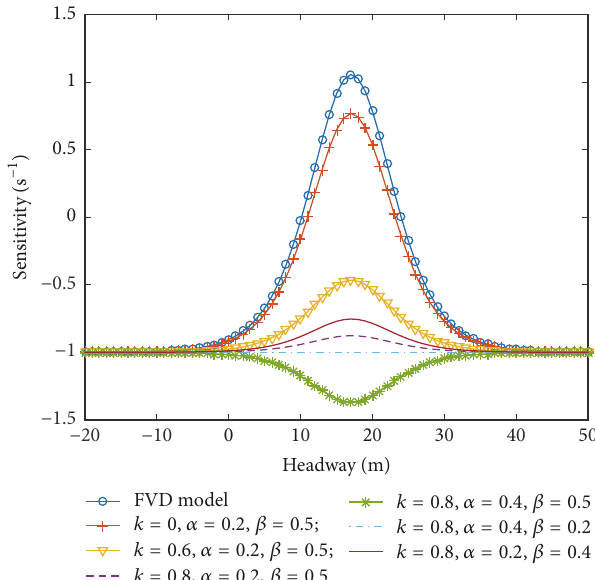
Figure 5: Neutral stability curves in headway-sensitivity space ( Δ𝑥,𝑎